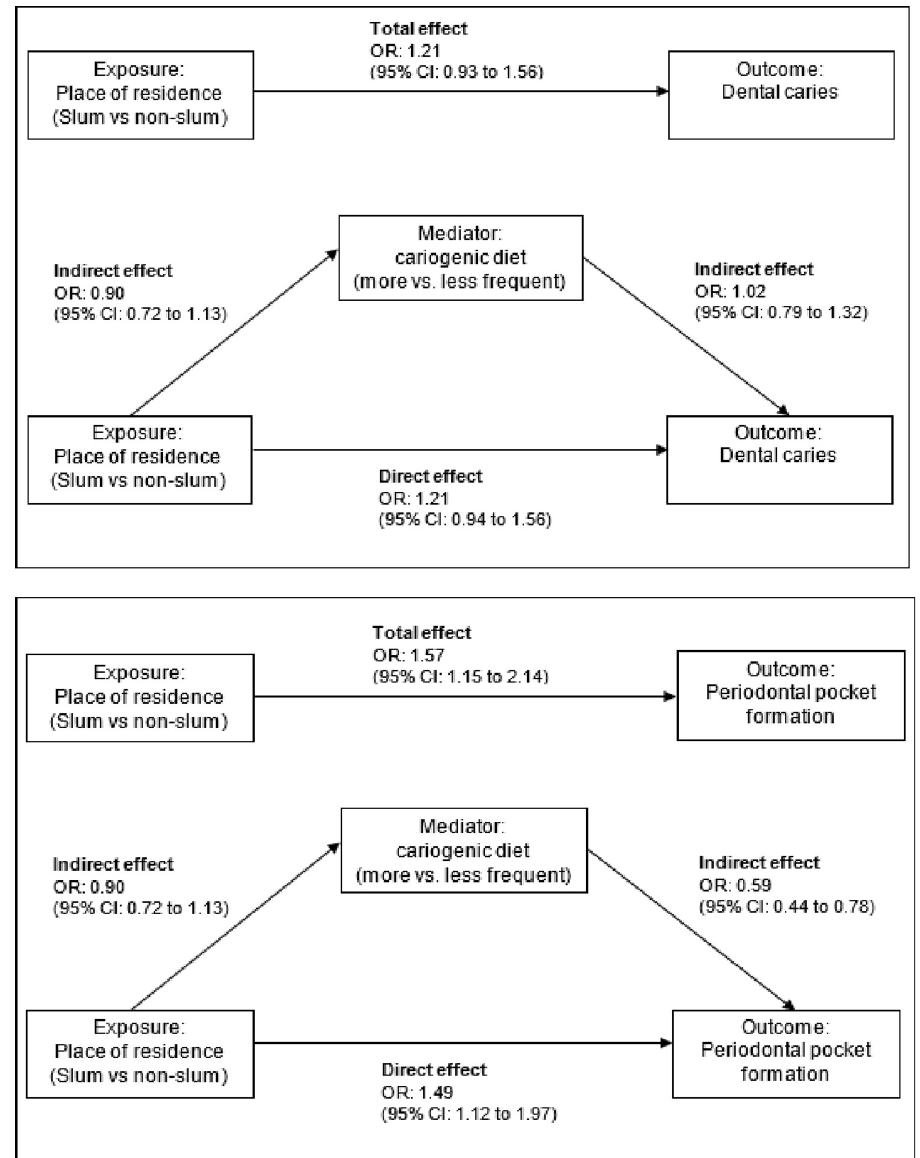
Fig 3. Causal pathways between place of residence and oral health outcomes (dental caries and periodontal pocket formation) with cariogenic diet as a potential mediator, controlling for age group and sex.